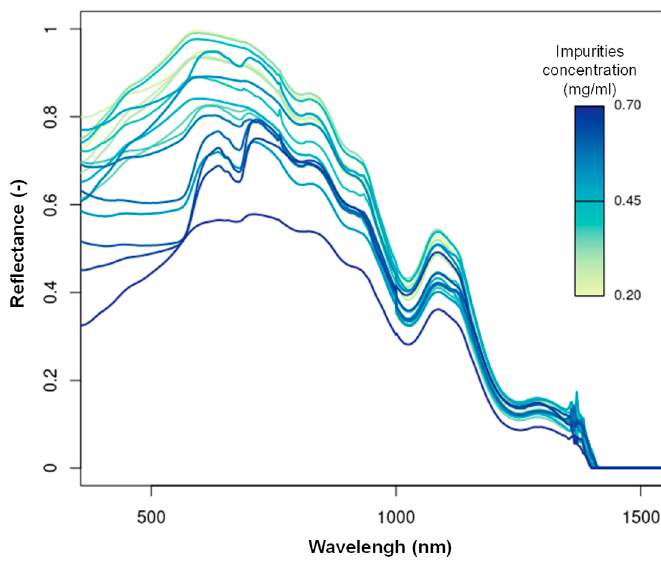
Figure 7. Surface snow spectra observed the 21 May 2019 on di ff erent locations in Izas Experimental Catchment. Color bar is indicative of di ff erent concentrations of impurities in the snow surface (in mg /